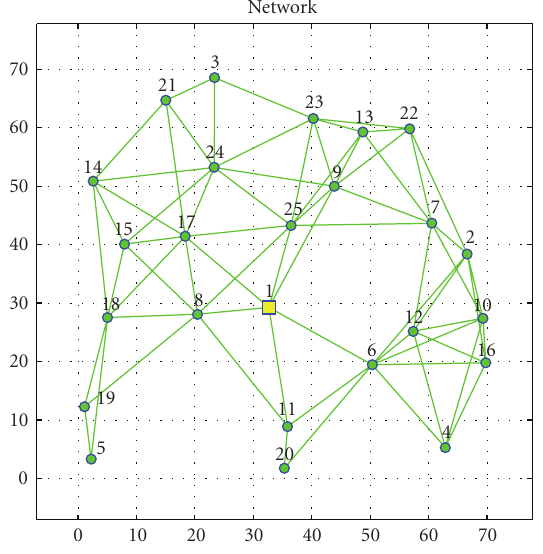
Figure 6: The considered sample network of 25 nodes.